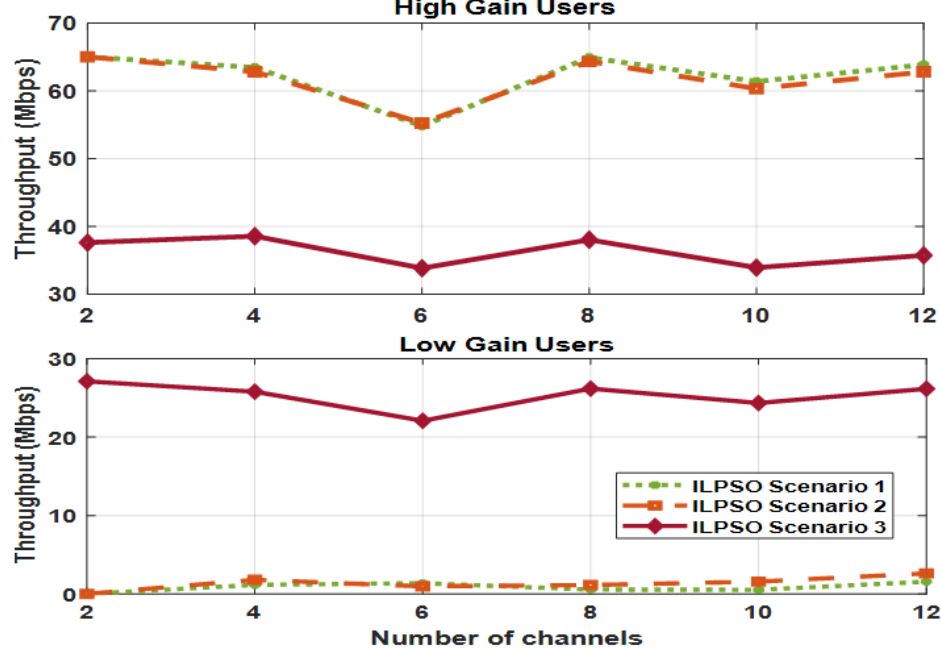
Figure 4. Achieved user throughput for high and low channel gain users.